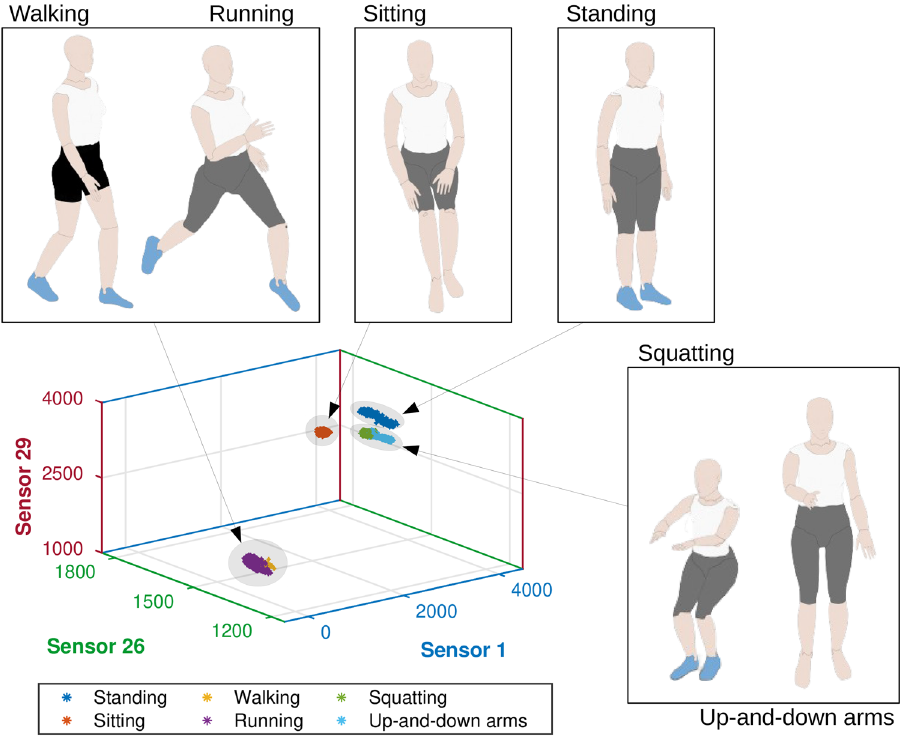
Figure 3. Clustering of six classes (activities) using the response of 3